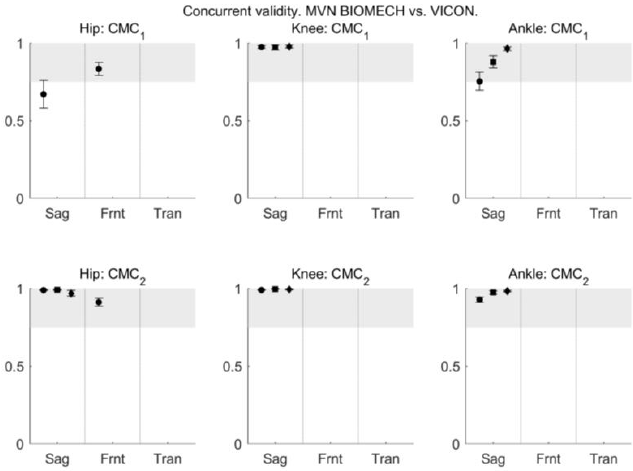
Figure 9. The coefficient of multiple correlation (CMC) between MVN BIOMECH and VICON data before (CMC 1 ; top row ) and after (CMC 2 ; bottom row ) offset removal for the hip ( left ), knee ( centre ) and ankle ( right ) joints in the sagittal (Sag), frontal (Frnt) and transverse (Tran) planes of movement. CMC is reported only for joints and planes where all values are real numbers [39]. Where there are three data points in each plane they correspond to the walk (left-most point; circle), squat (centre point; square) and jump (right-most point; diamond) tasks. Where there is only one data point it corresponds to the walk task. Error bars indicate 95% confidence intervals.